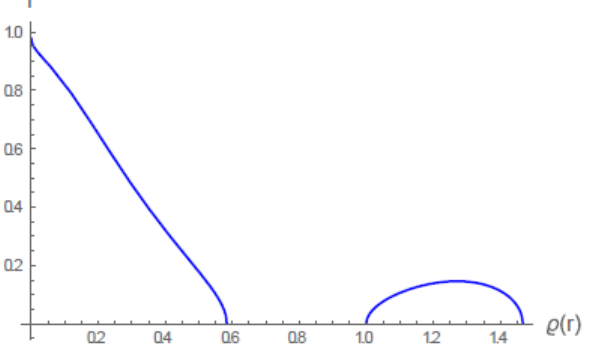
Figure 5. The multivalued isopotential (density profile) at t = 0.95 for the single choice of free parameter (cid:36) 0 = 1, which appears as the middle, unstable, value of the density at the origin r = 0. The smaller value near 0.58 and the larger value near 1.47 are not chosen as the parameter (cid:36) 0 ; they appear automatically as a consequence of the single choice (cid:36) 0 = 1. The portions of the profile featuring diminishing density as r increases are stable; the left-hand part of the “bulge”, with density increasing as r increases, is unstable